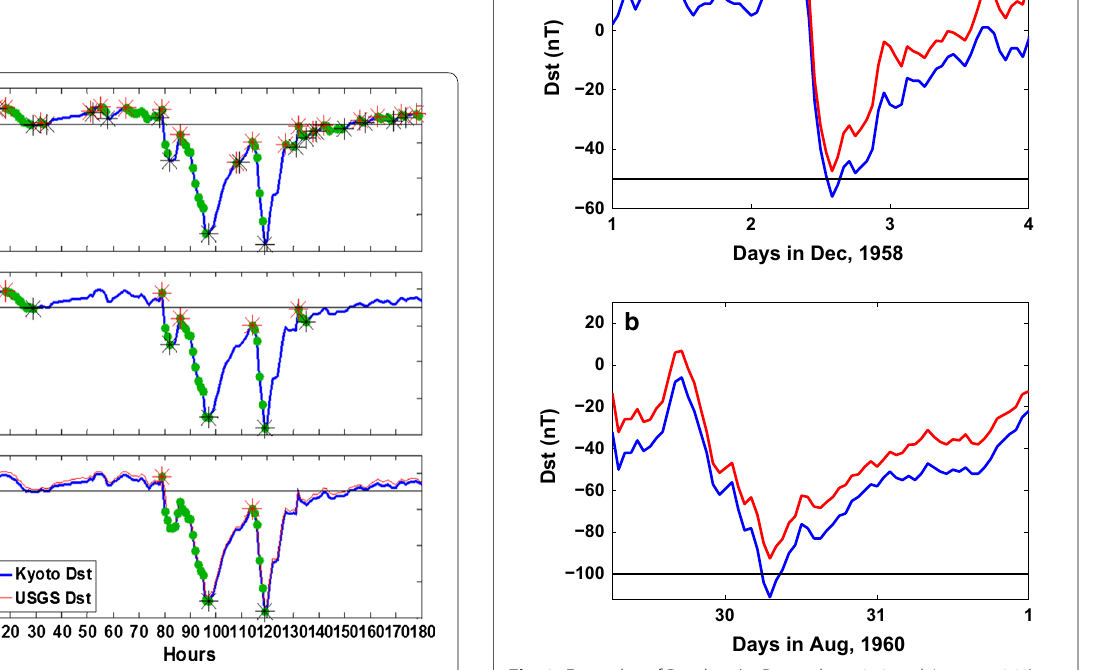
Fig. 1 An example of Kyoto Dst data (26 October–01 November 2003) illustrating the identification of Dst storms ( a , b and c ); USGS Dst data are also shown in c in red , see text